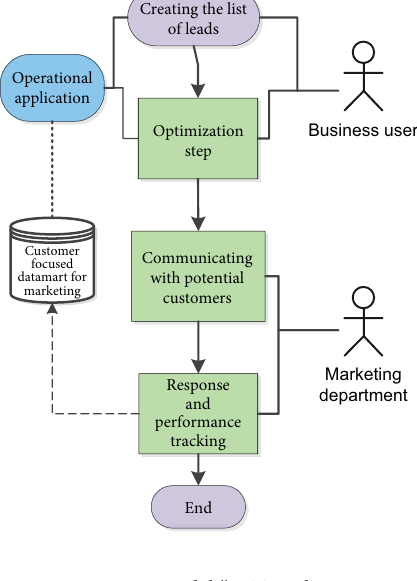
Fig. 3. Process model “AFTER data mining